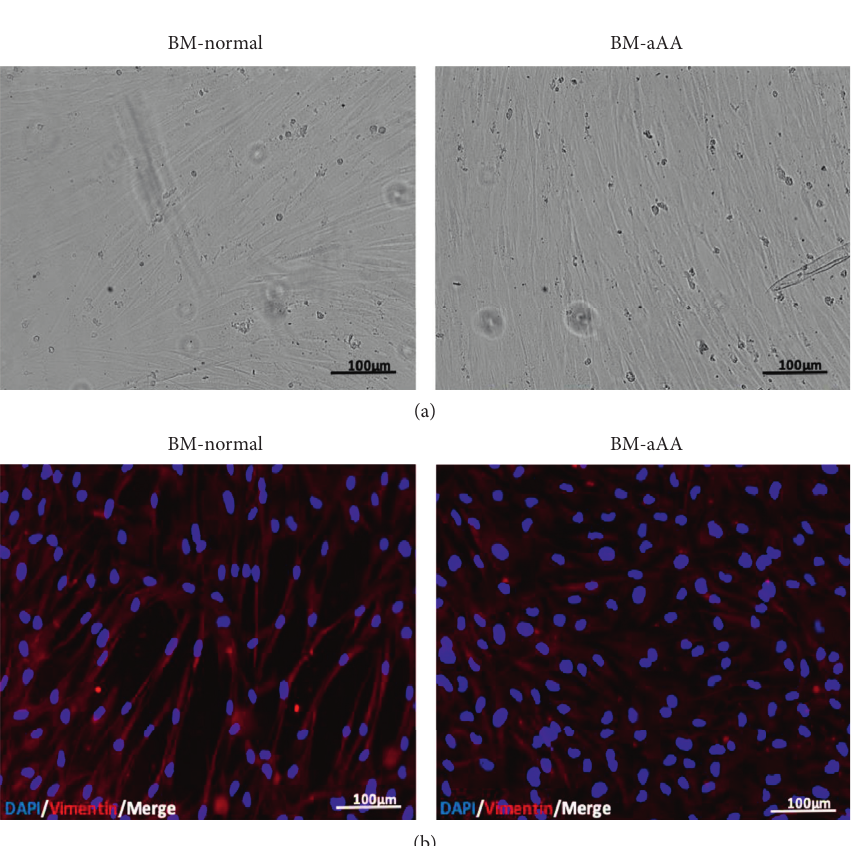
Figure 1: Representative images for BM-MSCs. (a) A micrograph to show typical spindle-shaped morphology of BM-MSCs from normal donor versus aplastic anemia. (b) An immunofluorescence image for vimentin expression level of vimentin in BM-normal vs.